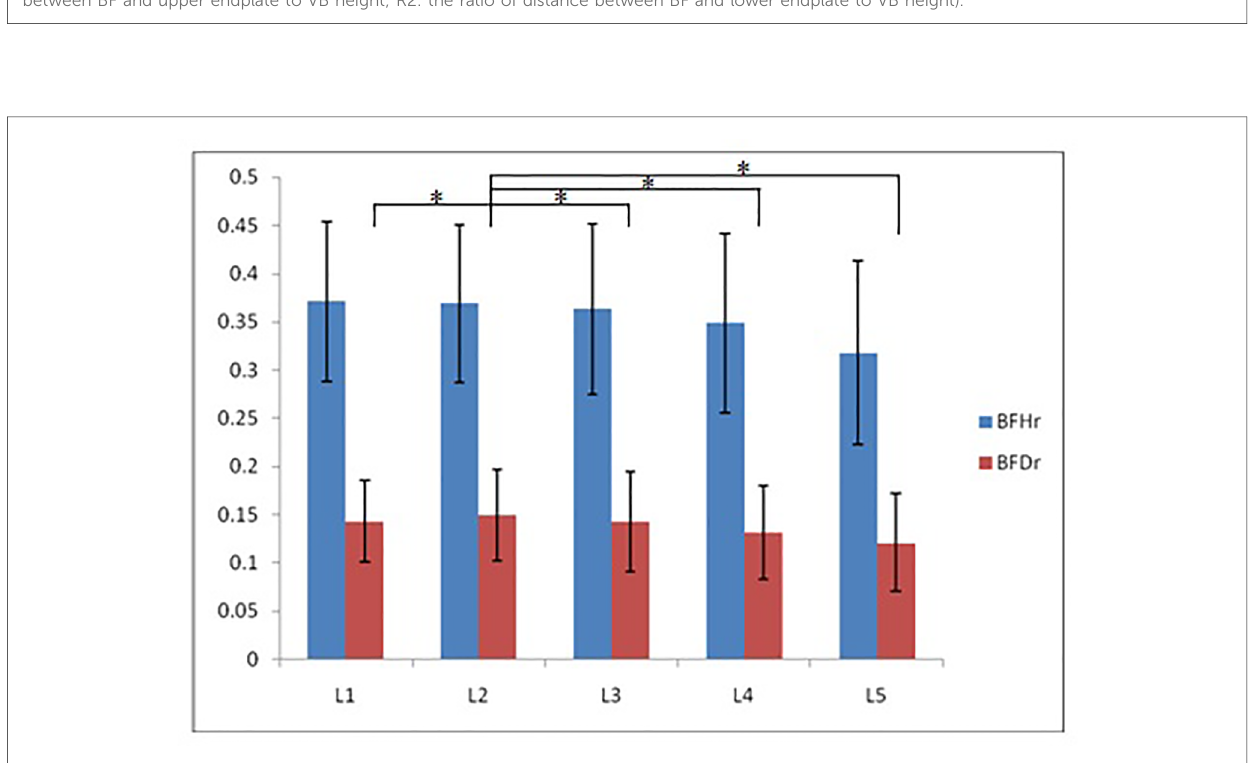
FIGURE 4 The BFHr at the lower level tends to be relatively smaller, while BFDr at L2 is the biggest among fi ve vertebral